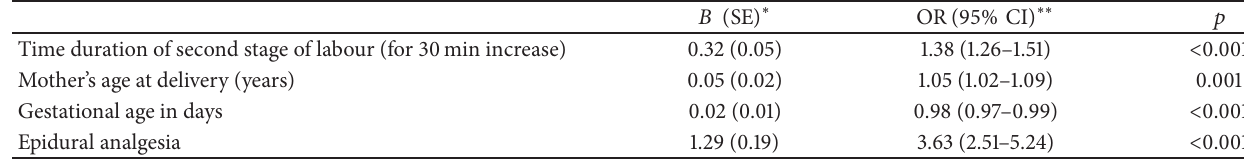
Table 3: Results from stepwise multivariable logistic regression analysis with the dependent variable presented route of birth (normal vaginal delivery ( 𝑁 = 646 ) versus instrumental delivery ( 𝑁 = 242 )).